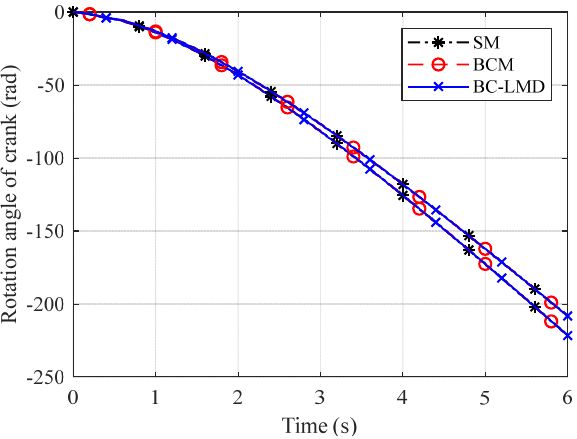
Figure 3. Bounds of the rotation angle of the crank.